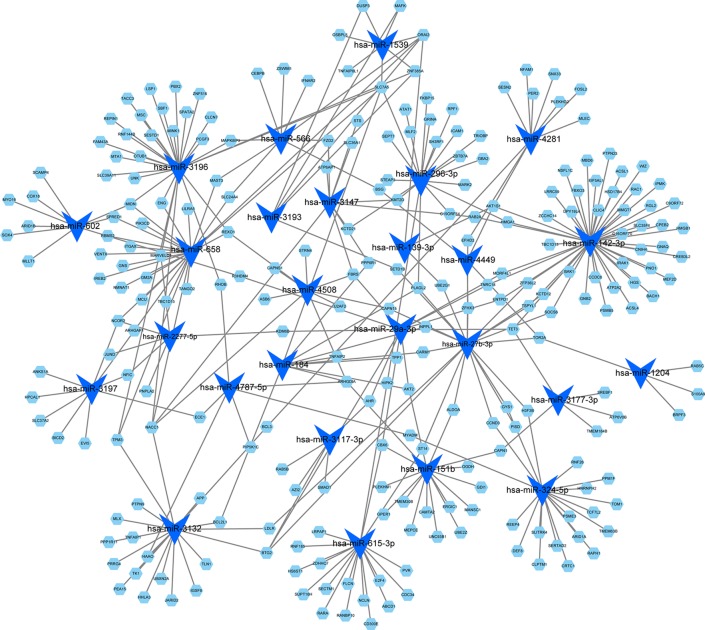
MicroRNA-target regulatory network for the blue module. Blue triangles represent the microRNAs, and green nodes represent the genes. The node size indicates the degree in the network.